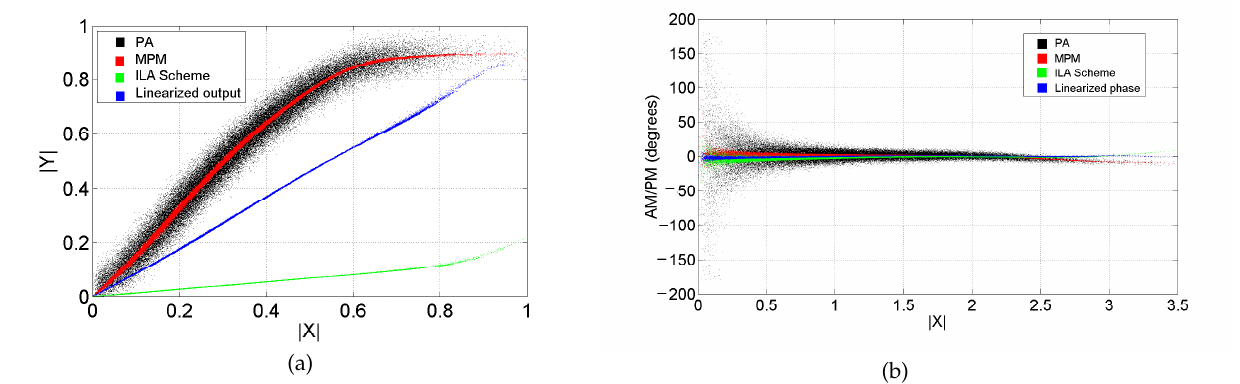
Figure 3. Linearization based on ILA based on MPM for the device NXP 10 W at 2.34 GHz. ( a ) AM/AM modeling and linearization stage and ( b ) AM/PM modeling and linearization stage.